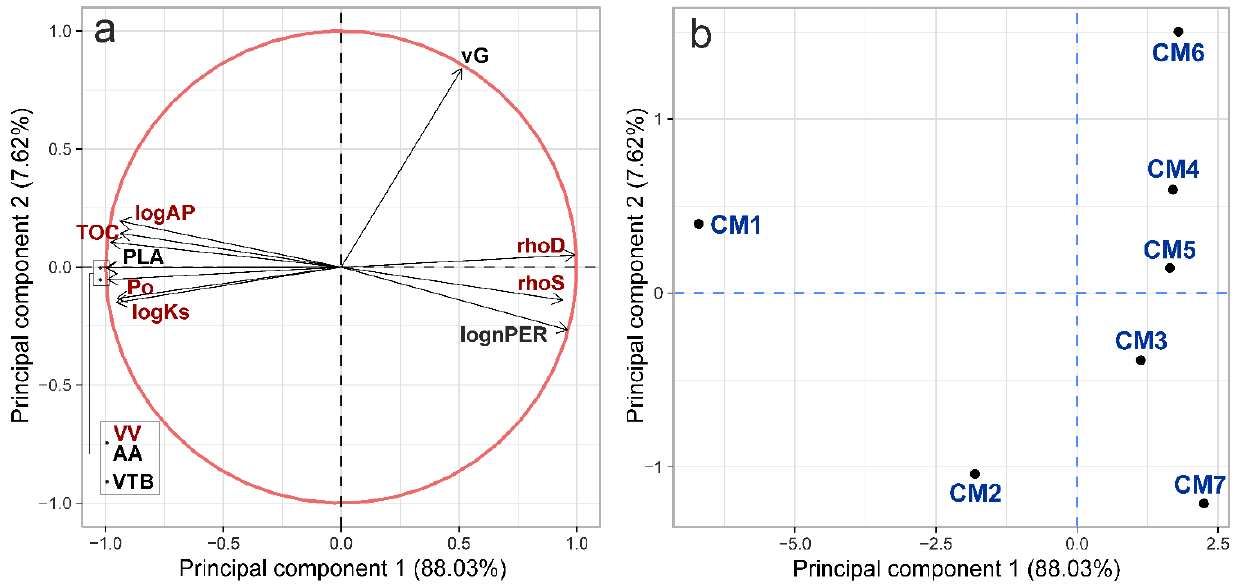
Figure 3. Principal component analysis (PCA) ( a ) loading and ( b ) score plot of Cambisol physicochemical (in red) and morphometric parameters (in black) and soil layers (in blue). logAP–air permeability at −15 kPa; PLA–relative length of pore path; TOC–total organic carbon; VV–air content at −15 kPa; AA–macroporosity by image analysis; VTB–relative volume of pores overlapping the top and bottom edge of the image; Po–total porosity; logKs–hydraulic conductivity; vG–pore-network growth-rate; rhoD–bulk density; rhoS–particle density; lognPER–percolation number; and CM1…CM7–Cambisol layers 1…7, respectively.